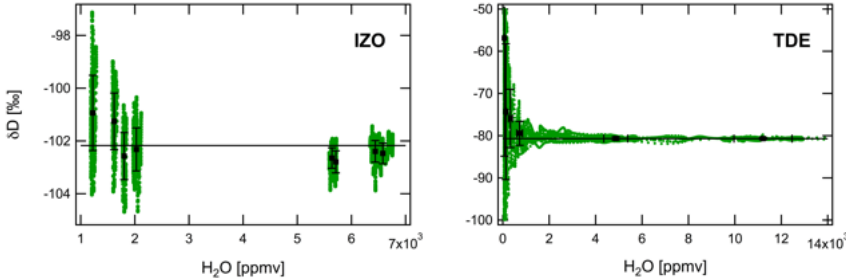
Figure A3. Measured humidity dependence of δ D determined by measuring water vapour produced in a bubbler dilution system at IZO (left) and TDE (right) stations respectively. Data shown are 1min averages. The error bars indicate the 1 σ standard deviation of the δ D measurements, within which the average δ D of each humidity bin (black symbols) are identical to the average of all